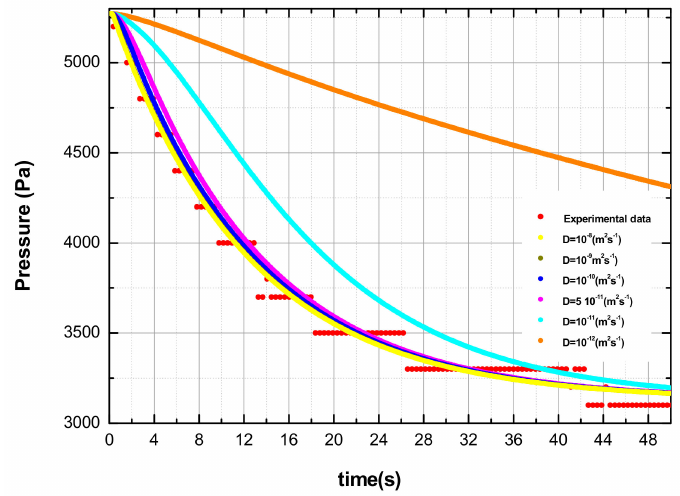
Figure 4. Behavior of the calculated pressure curves as a function of time; the various curves are obtained with di ff erent values of the di ff usion coe ffi cient. The experimental data are also reported (set 9 in Table